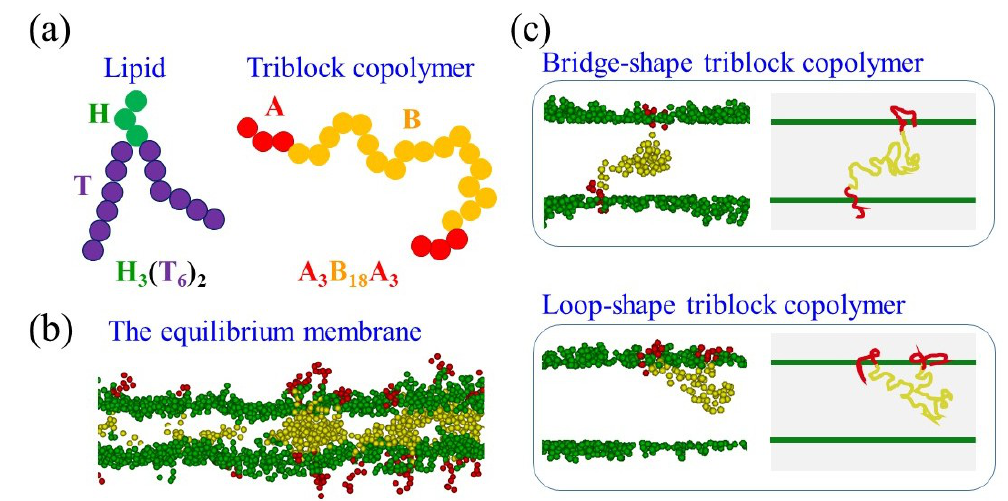
Figure 1. ( a ) Schematics of model lipid and triblock copolymer, ( b ) the sliced snapshot of the equilibrium hybrid membrane, and ( c ) snapshots and schematics of the bridge-shape and the loop-shape triblock copolymers. Note that in ( b ) and ( c ), lipid tails are omitted. Green and purple beads represent lipid head and tail, respectively. Red and yellow beads denote hydrophilic and hydrophobic parts of the copolymer, respectively.